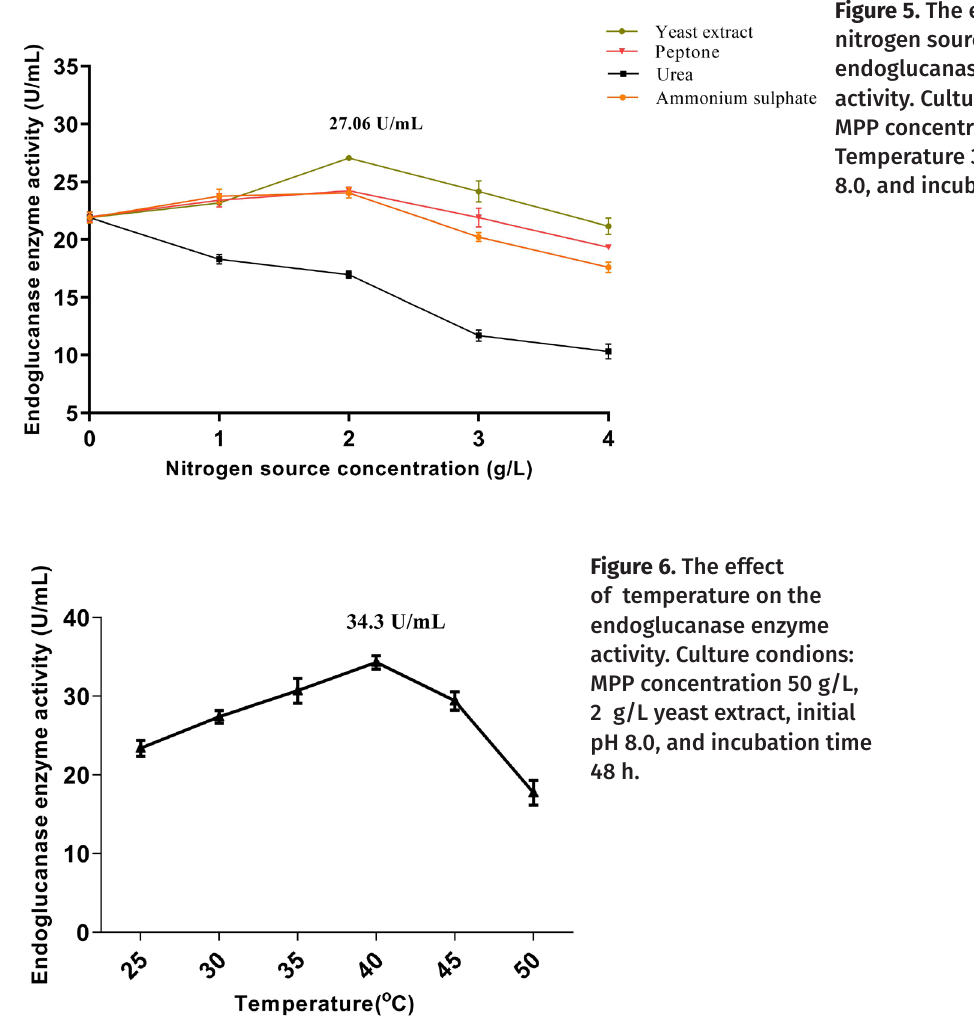
Figure 5. The effect of